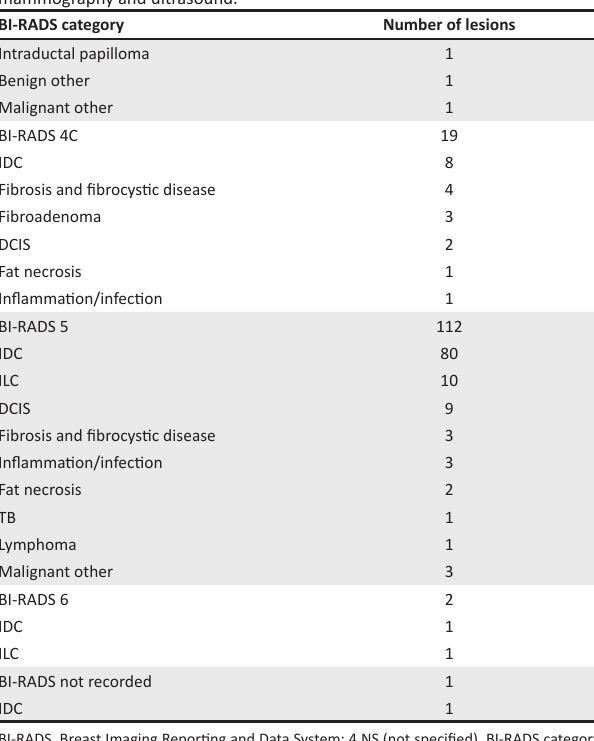
FIGURE 3: Summary of the number of lesions assigned a BI-RADS category. TABLE 2: Histological diagnoses of the ultrasound-guided core-needle breast biopsy in each BI-RADS category for lesions assessed with mammography and ultrasound.